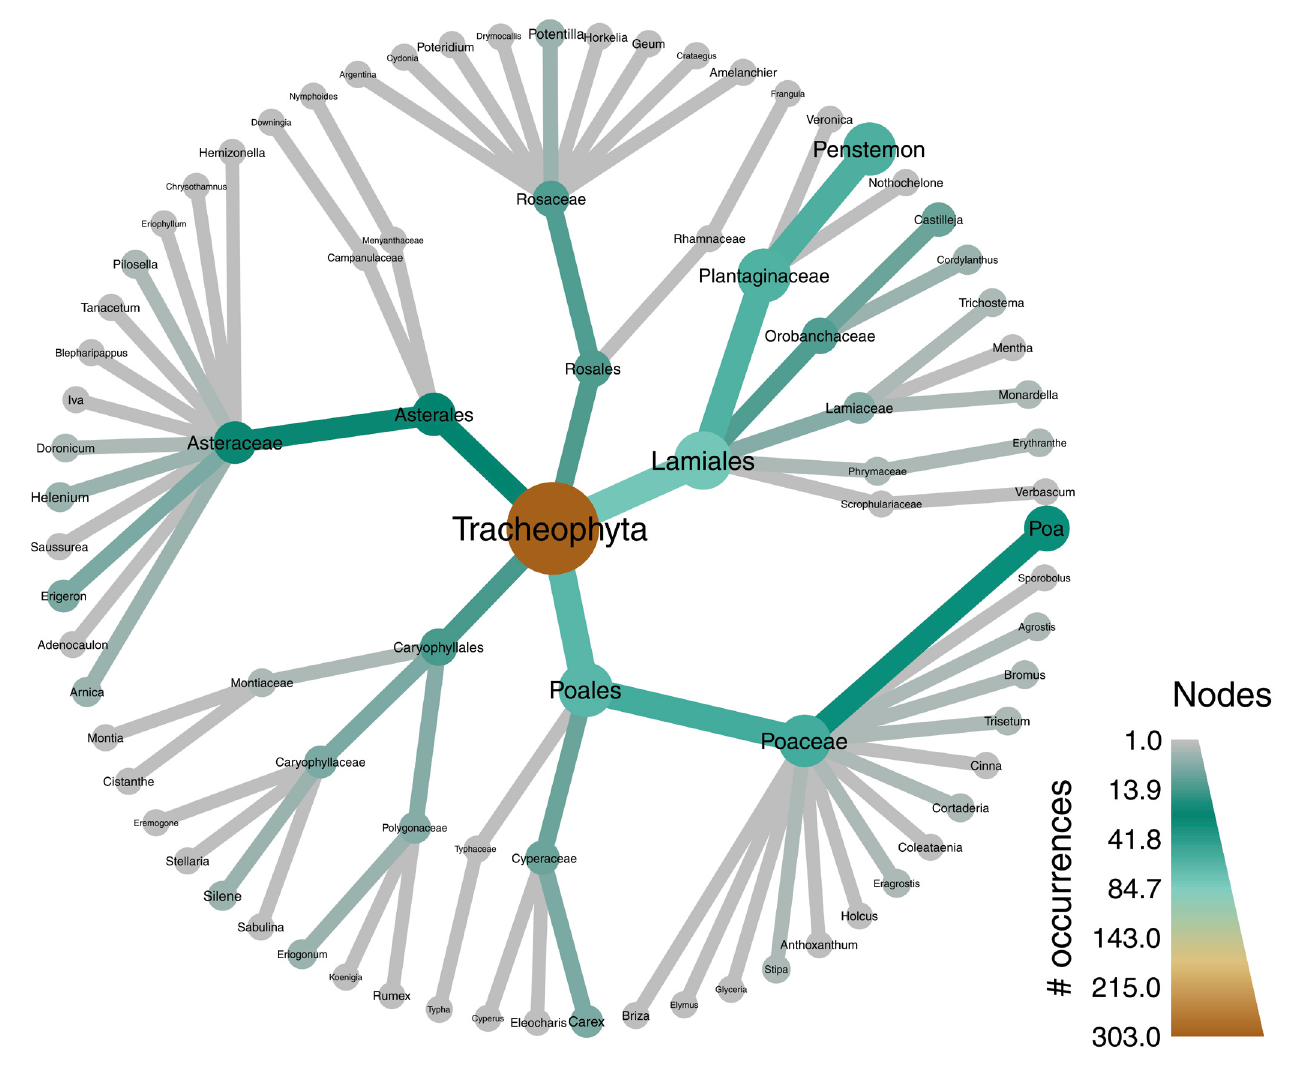
Figure 3. The result of the example analysis shown in the text. Records of plant species occurrences in Oregon are downloaded from the Global Biodiversity Information Facility (GBIF) using the rgbif package (Chamberlain, 2017). Then a taxa parser is used to parse the table of GBIF data into a taxmap object. A series of filters are then applied. First, all occurrences that are not from preserved specimens as well any taxa that have no occurrences from preserved specimens are removed. Then, all taxa at the species level are removed, but their occurrences are reassigned to the genus level. All taxa without names are then removed. In the final two filters, only orders within Tracheophyta with greater than 10 subtaxa are preserved. The metacoder package is then used to create a heat tree (i.e. taxonomic tree) with color and size used to display the number of occurrences associated with each taxon at each level of the hierarchy.